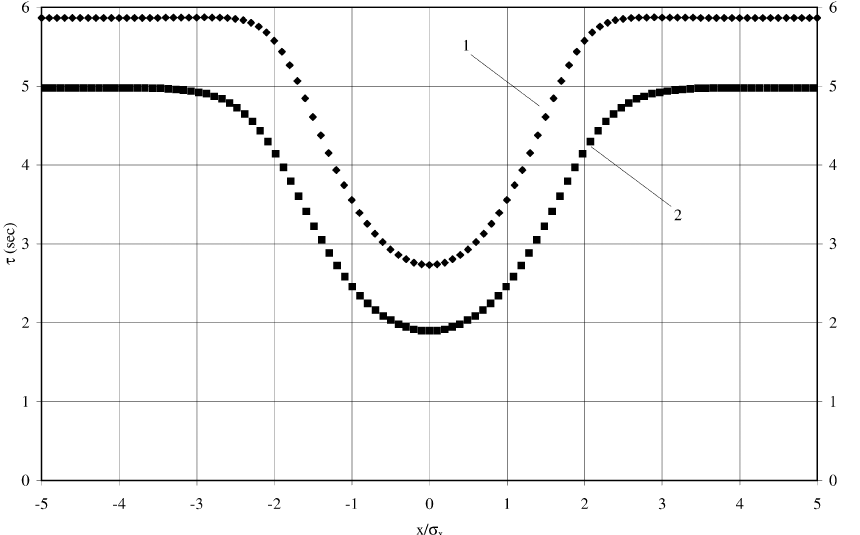
FIG. 4. Wire thermalization time t depending on distance from beam center, d 1 (cid:1) 30 m m, d 2 (cid:1) 10 m m.